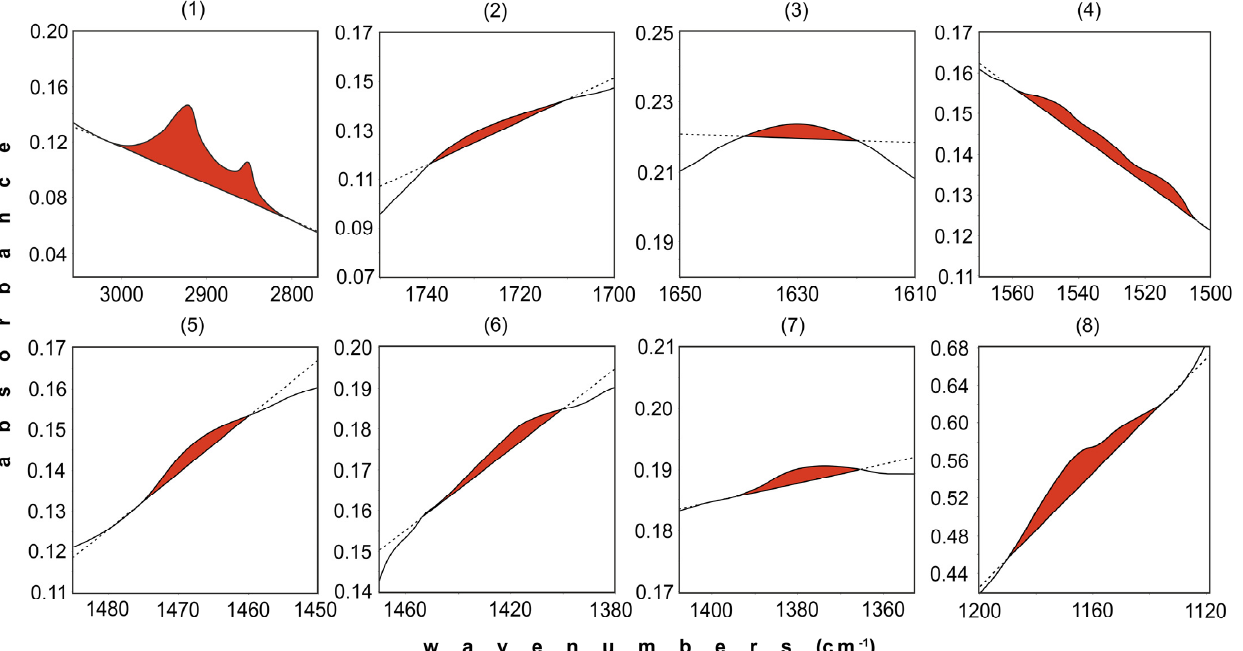
Figure 2. Illustration of peak area integration in 8 infrared bands.